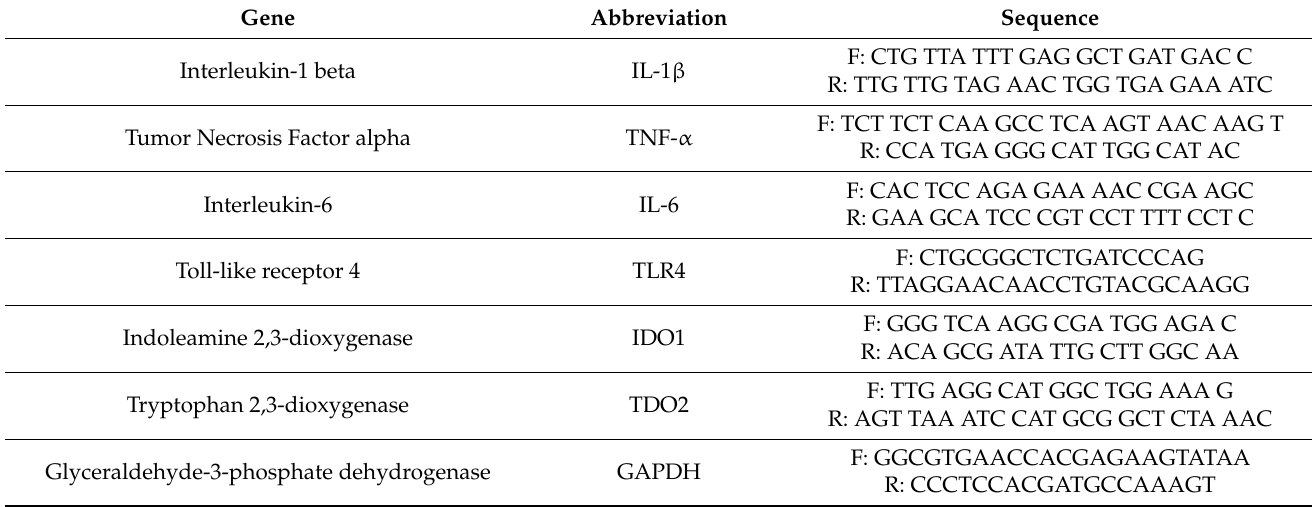
Table 1. Primer sequences used for real-time RT-PCR